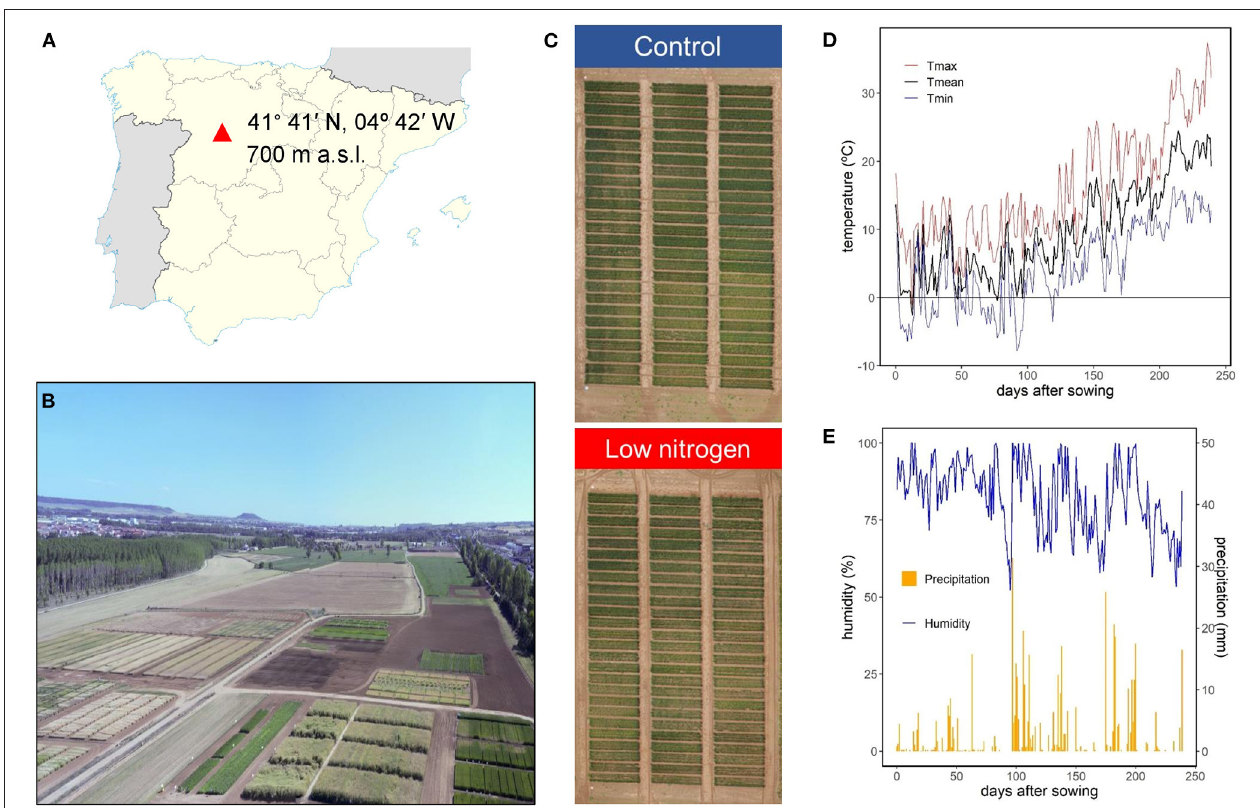
FIGURE 1 | Location (A) and aerial images (B,C) of the field trials, and daily mean (T mean), maximum (T max), and minimum (T min) temperatures (D) , relative humidity, and precipitation (E) during the crop season from November 23, 2017 to July 20, 2018 (D)